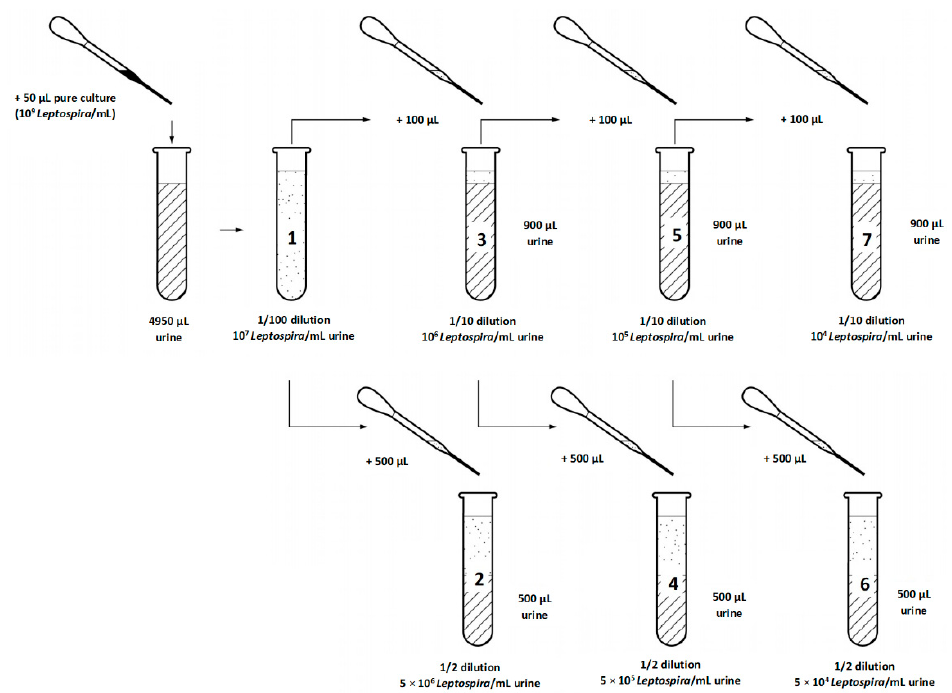
Figure 2. Experiment 2: Steps of preparation of seven dilutions of pure culture (10 9 Leptospira /mL) in each of ten selected urine samples before transfer into culture medium (EMJH-STAFF).